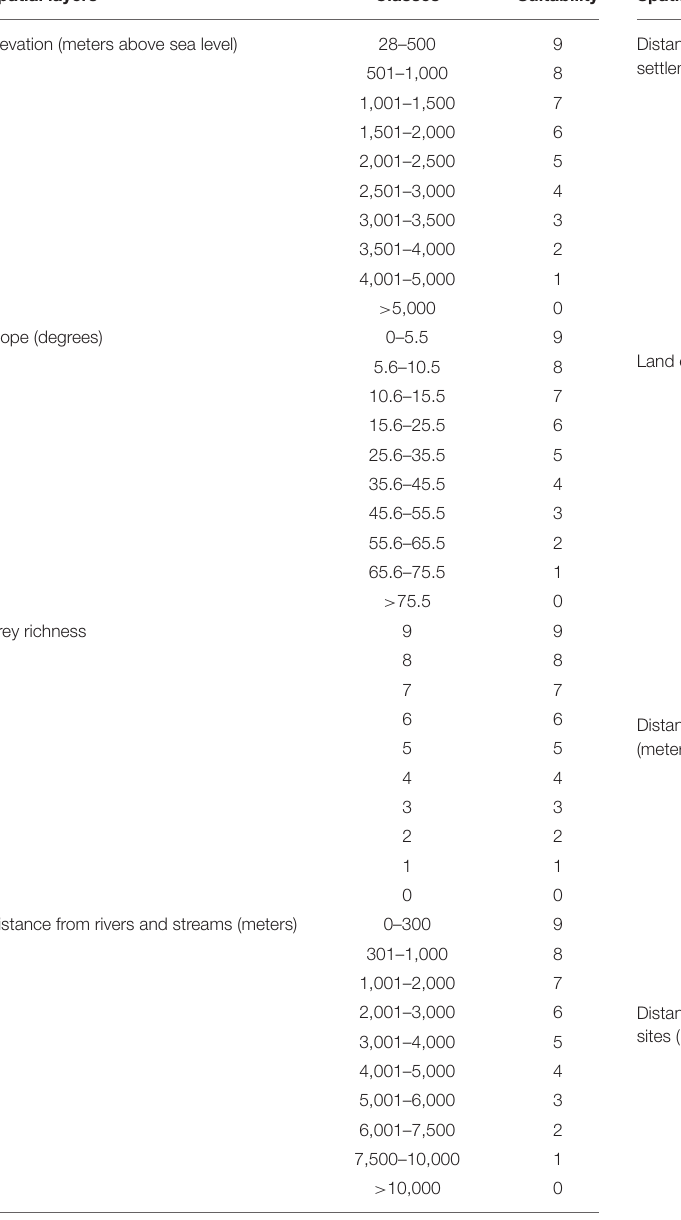
TABLE 1 | Geophysical and biological variables with suitability values for dholes ( Cuon alpinus ) in Bhutan. Spatial layers